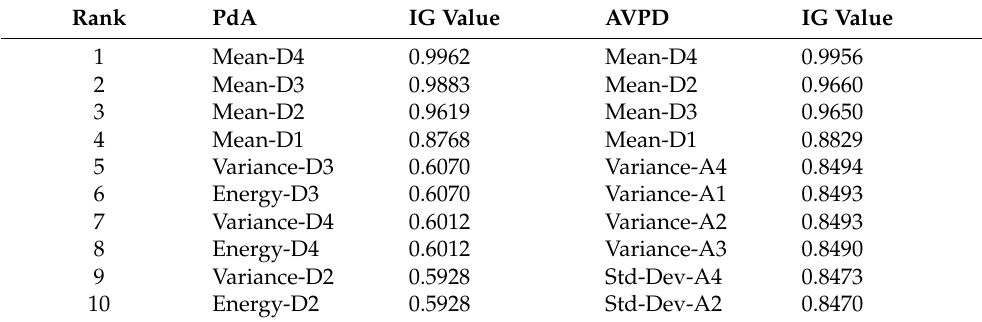
Table 11. Top 10 ranked descriptors with 15 pathologies from PdA and five from AVPD.